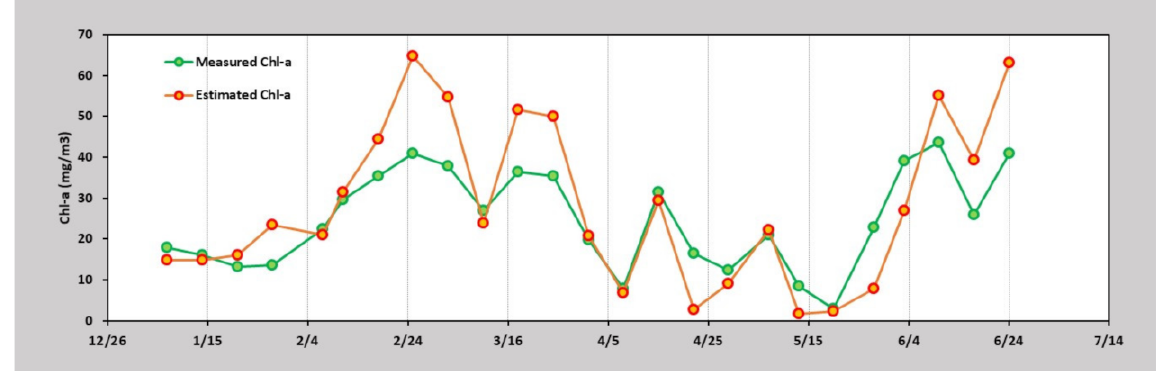
Figure A4. Comparison of measured and converted chlorophyll-a